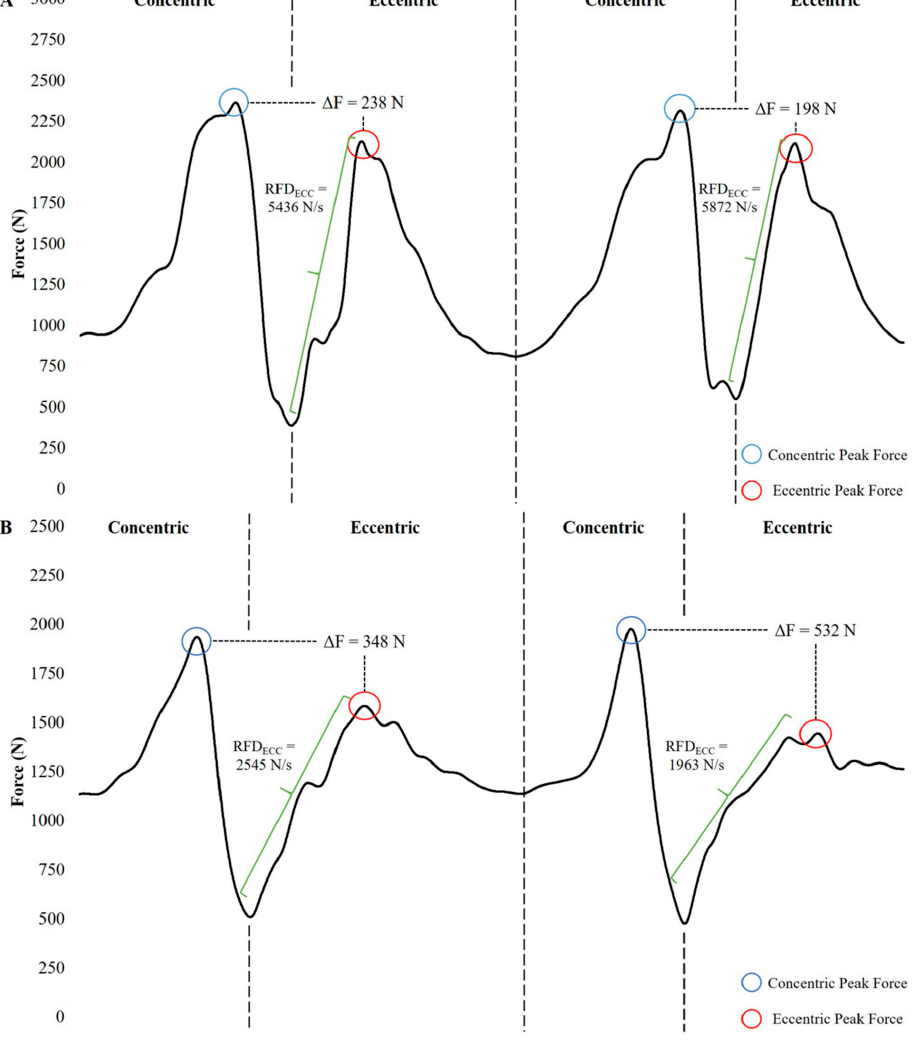
Figure 1. Force–time curves of flywheel squats performed with a fast-concentric action and slow- eccentric action by a weaker, heavier male ( A ) and a stronger, lighter male ( B